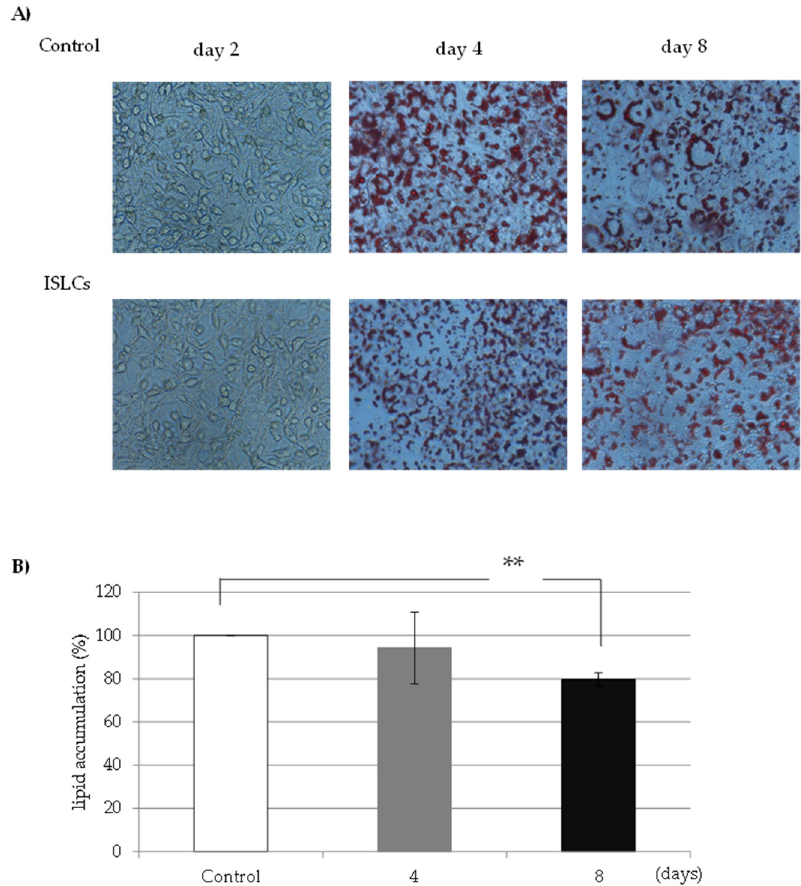
Figure 1. ISLCs on fat accumulation in adipocytes. ( A ) Lipid droplets of control cells and ISLCs-treated cells after Oil Red O staining. ( B ) Comparison of lipid accumulation in 3T3-L1 cells. Cell culture was cultivated for 8 days in medium including various kinds of extracts of indigestible sake lees component powder (ISLCs). Fat accumulation was expressed relative to untreated control cells (100%). Values are expressed as mean ± SD; different from control cells; ** p < 0.01 (n = 3).